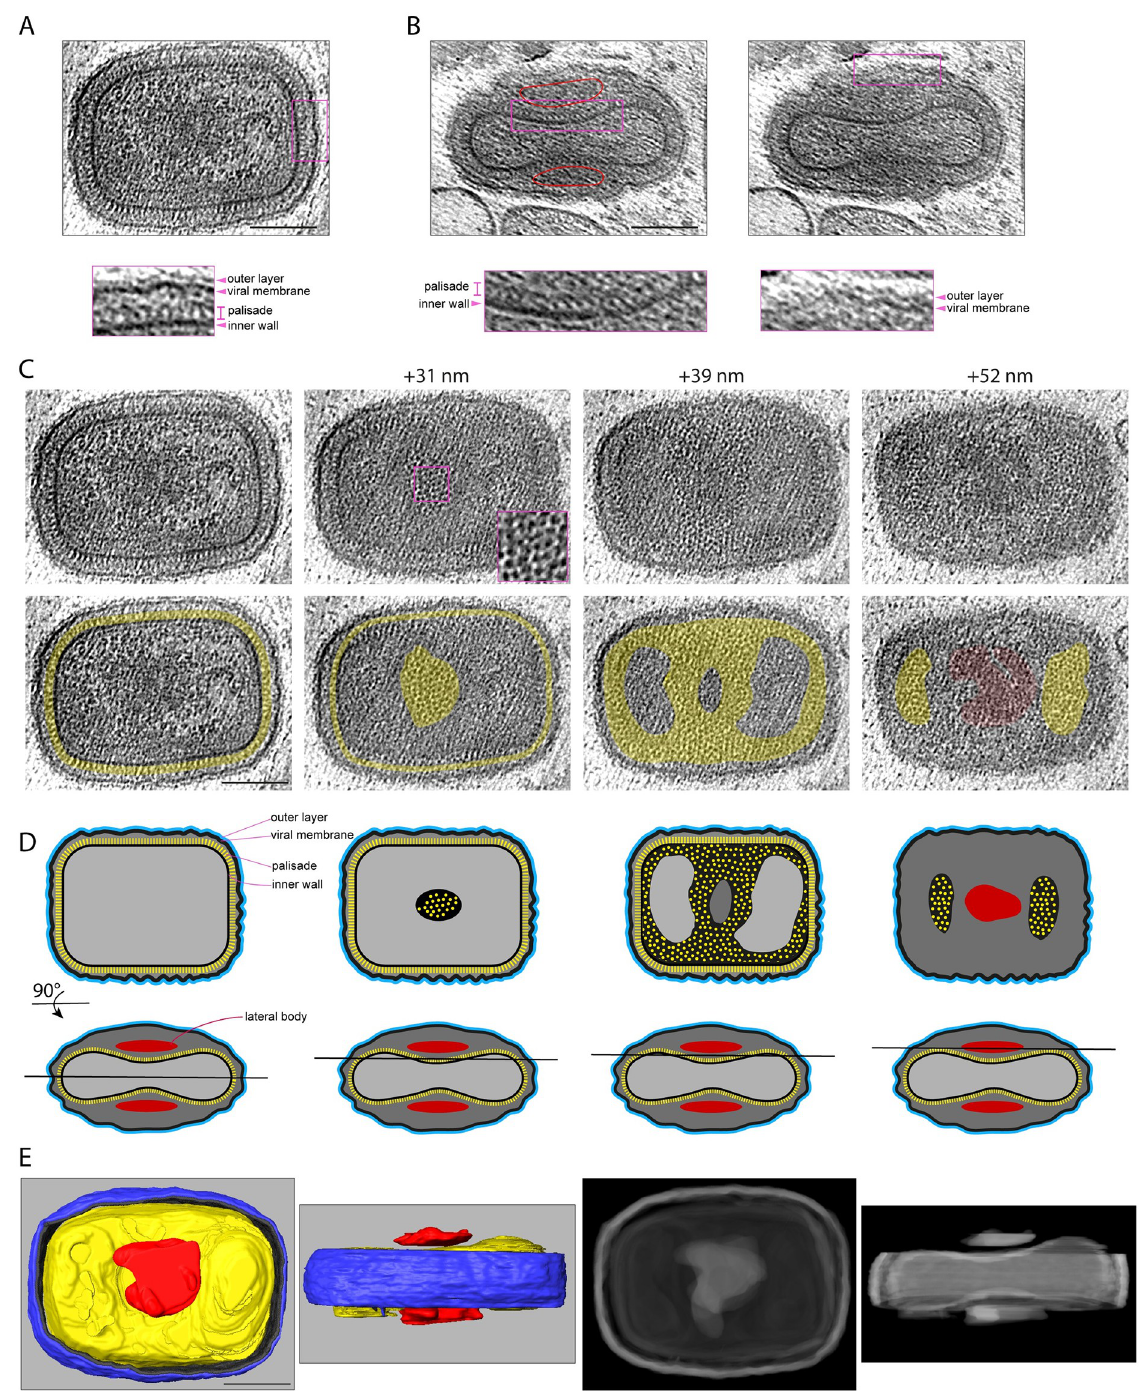
Fig 5. Ultrastructure of IMV. ( A ) Central tomogram section showing the broadest view of a representative IMV together with a region magnified 2.5 times to highlight the IMV layers (see S5 Movie). ( B ) Lateral view of an IMV showing the lateral bodies (outlined in red) and the two concavities of the core. The magnified regions outlined in magenta show the IMV layers. ( C ) Different sections of the IMV shown in (A) at the indicated plane positions in nm. The inset in the +31 nm view shows the surface of the palisade lattice. In the second row, yellow highlights the palisade structure, while red indicates the lateral body. ( D ) The first row shows a schematic representation of the views displayed in (C), while the second row represents the orthogonal view together with the tomogram position (black line). ( E ) Left: top and side views of a segmentation model of the IMV in (A). The outer layer (blue) and viral membrane (black) are cut away so the internal palisade (yellow) and the lateral bodies (red) can be seen (see S6 Movie). Right: The 2 concavities of the core are more apparent in a Simulated Digitally Reconstructed Radiograph (DDR Rendering) of the same segmentation model. Scale bars = 100 nm. IMV, intracellular mature virion.